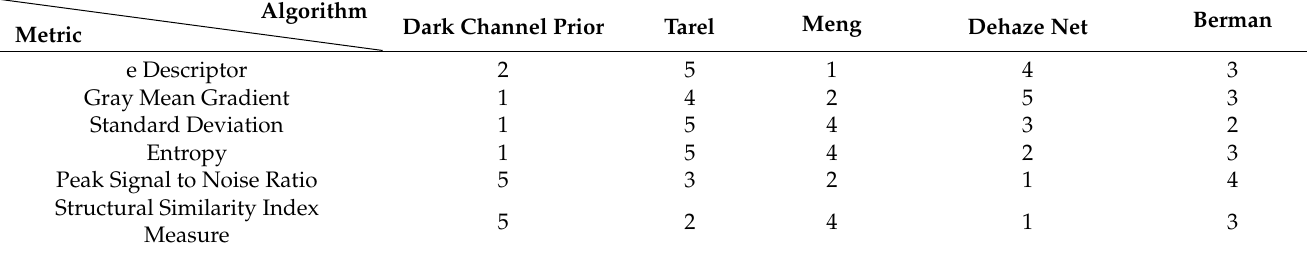
Table 2. Dehazing algorithms comparison from a metrics point of view. Medium haze conditions are considered. The table presents the ranking (from 1 to 5) Data from the table are extracted from